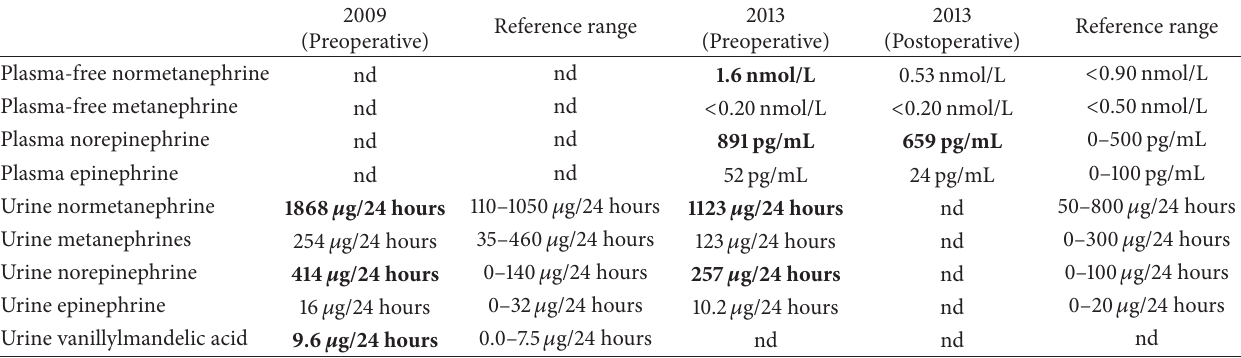
Table 1: Patient’s catecholamine levels before and after left